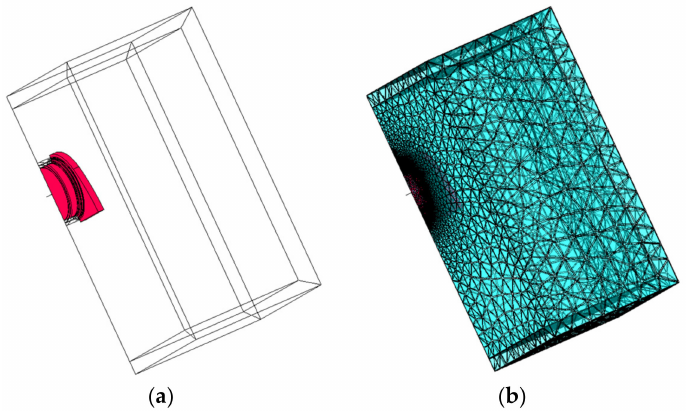
Figure 3. A quarter-pin model in the electromagnetic field (( a ) Geometric model; ( b ) mesh model).